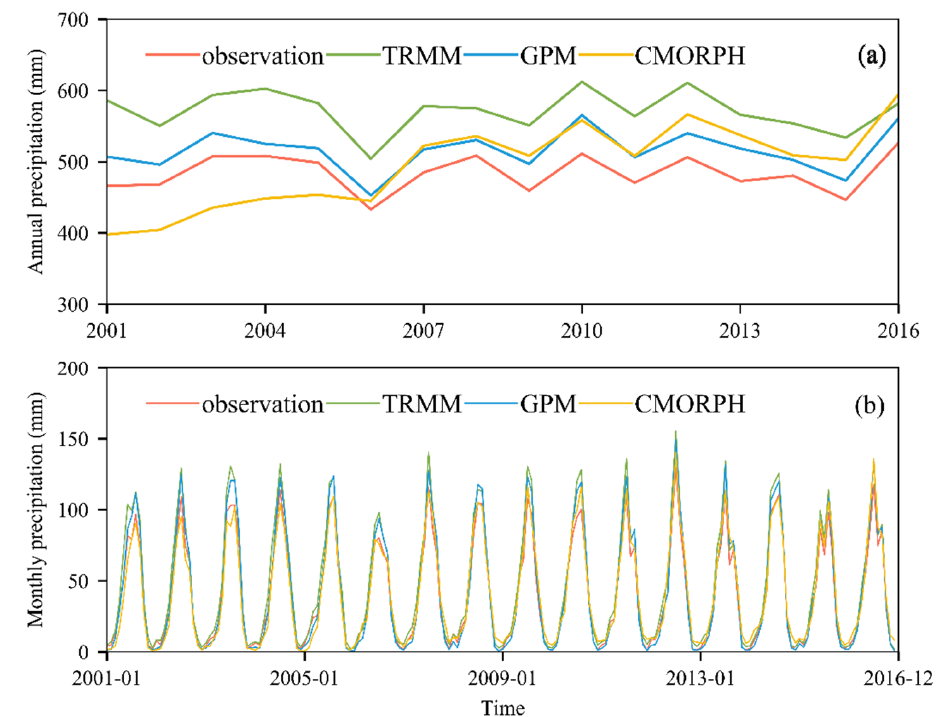
Figure 2. ( a ) Annual and ( b ) monthly precipitation time series of three remote sensing precipitation products and gauge data during the study period on the Tibetan Plateau.